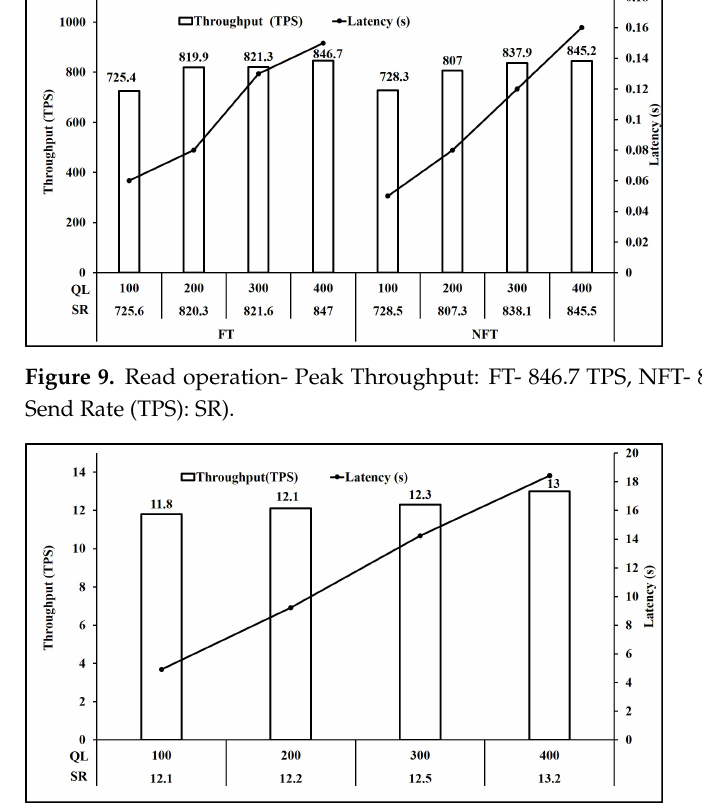
Figure 10. NFT Bulk Read Operation. Peak Throughput 13 TPS (Queue Length: QL, Send Rate (TPS):